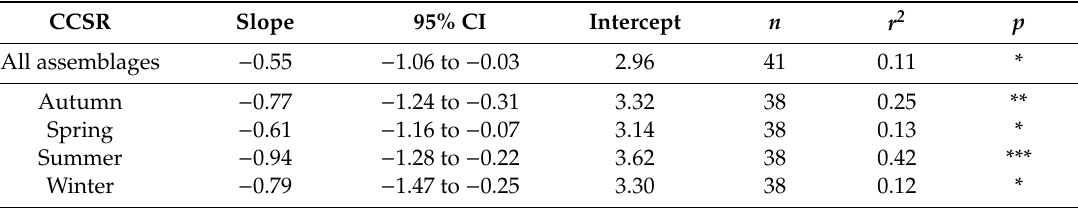
Table 3. Results of LSR analyses of log10 population abundance (number of individuals) in relation